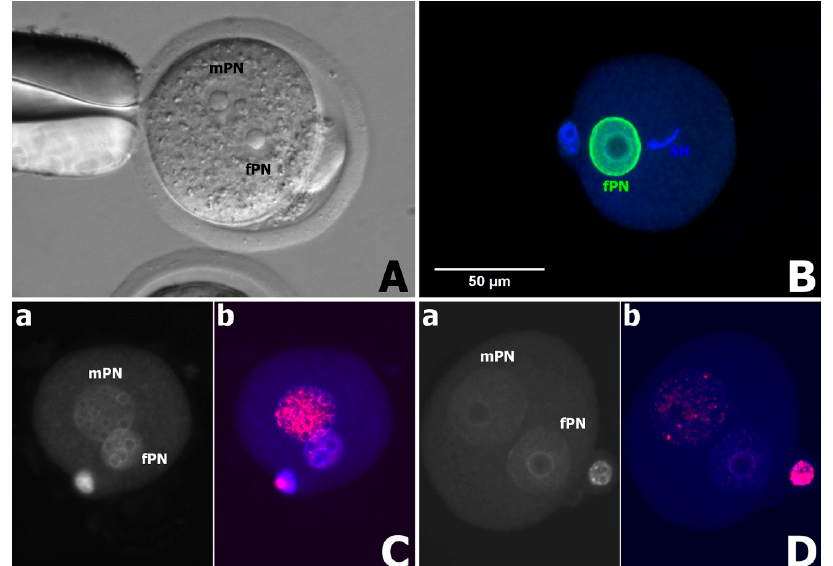
Figure 2. Representative pictures demonstrating the behavior of sperm heads after interspecific ICSI. ( A ) Goat sperm in mouse oocytes forms large mPN with several nucleoli. Maternal, female—fPN is always smaller. ( B ) Rooster sperm (SH) does not respond to mouse oocyte cytoplasm whilst the maternal (fPN) is normally formed. ( C ) Heavily damaged sperm DNA (mPN) exhibits very intensive labeling against ɣ H2AX—( a ) DNA staining with Hoechst (mPN—sperm, fPN—maternal pronucleus), ( b ) parallel picture showing very intensive ɣ H2AX signal in mPN. ( D ) Only weak labeling against ɣ H2AX is detected over mPNs when fresh spermatozoa are used for ICSI (( a )—Hoechst staining, ( b )— ɣ H2AX labeling).